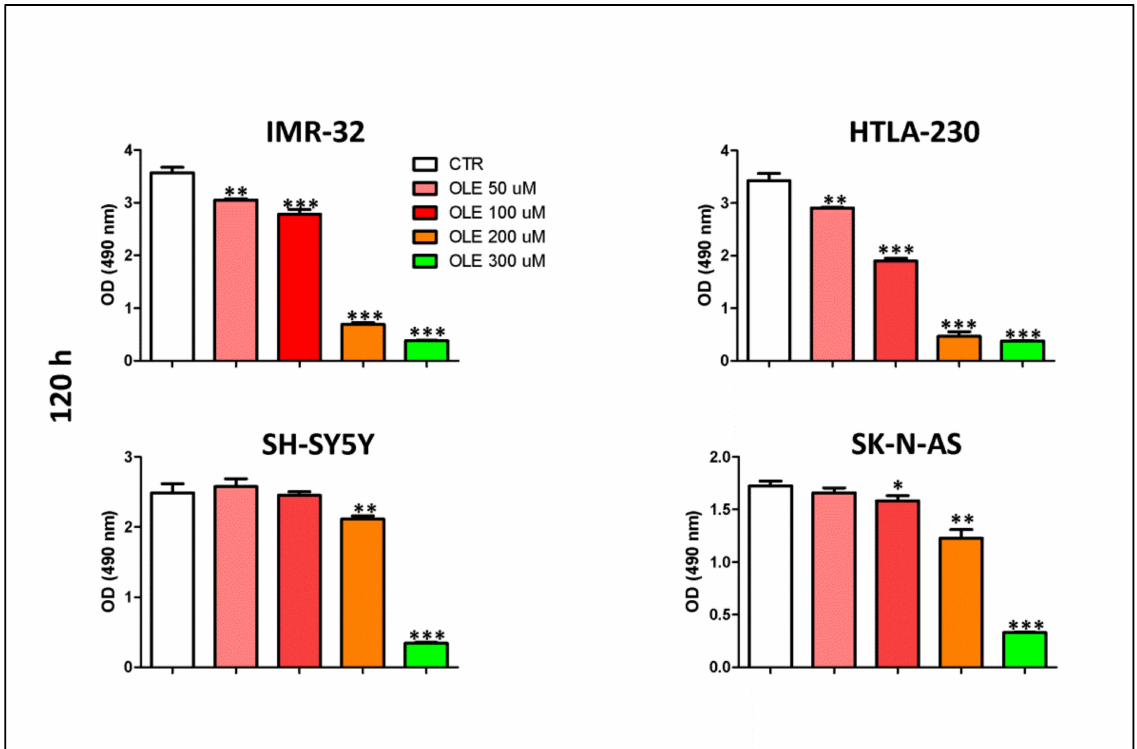
Figure 1. Dose-dependent effects of OLE treatment on the cell viability of NB cells. Data represent the results of MTS assays performed after 120 h of OLE treatment. Optical density (OD, at 490 nm) was recorded by the use of the TECAN micro-plate reader, Infinite 200 (Tecan Life Sciences). Data are expressed as mean ± SD of three independent experiments (* p < 0.05, ** p < 0.01, *** p < 0.001 vs CTR). CTR: control; OLE: olive leaf extract; uM: micromolar; nm: nanometer; h: